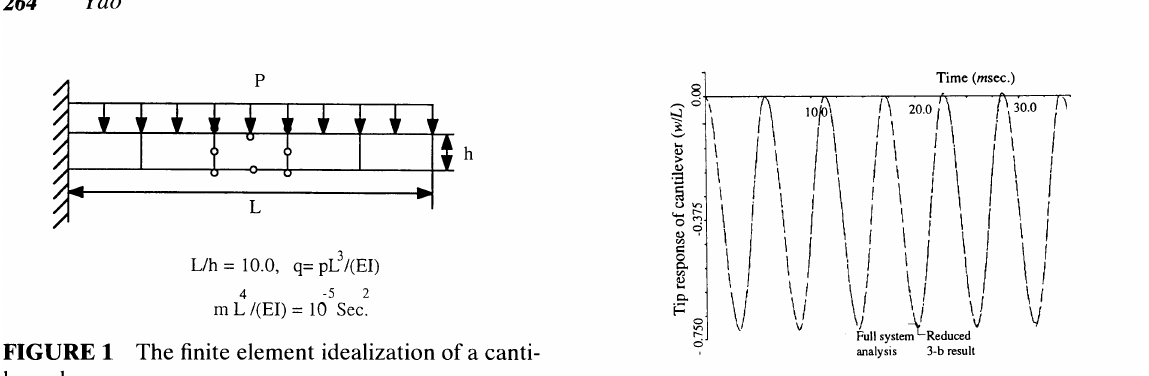
FIGURE 4 Cantilever under step load. Comparison of tip response between full system and reduced 3- basis linear analysis.